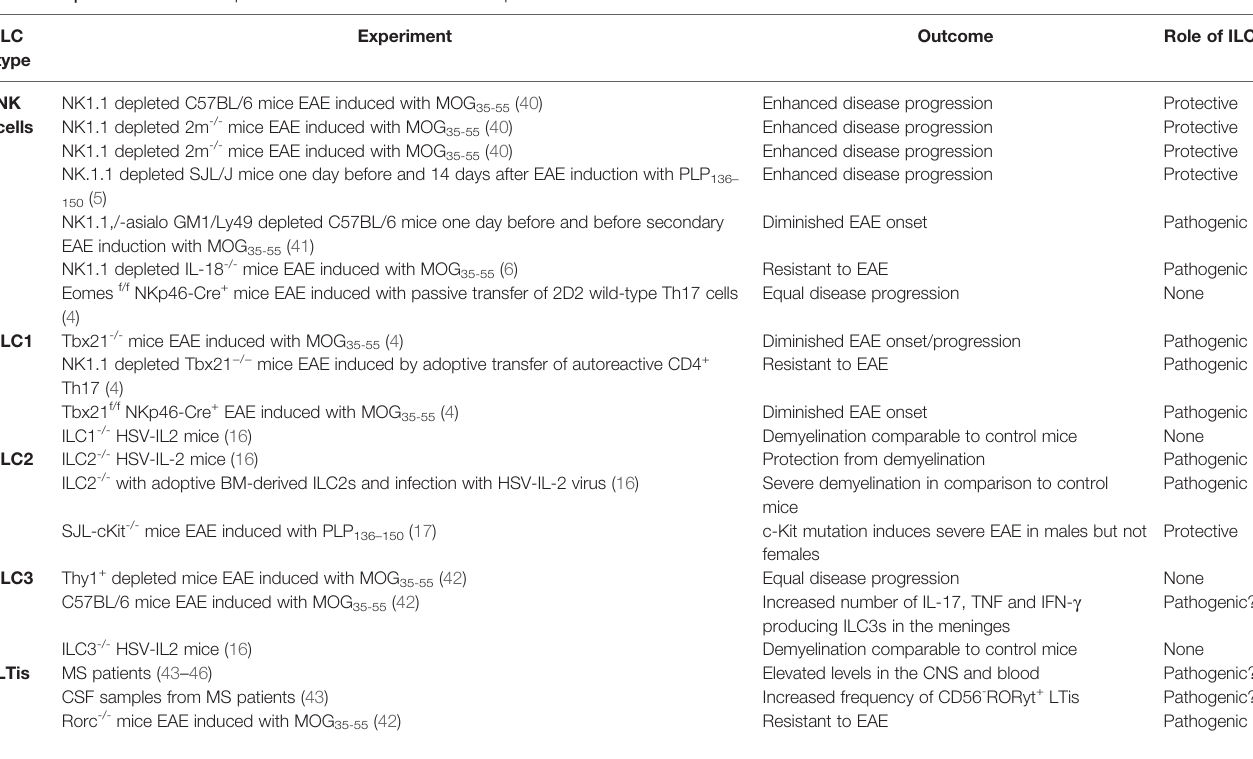
TABLE 1 | Overview of ILCs in preclinical models of MS and in MS